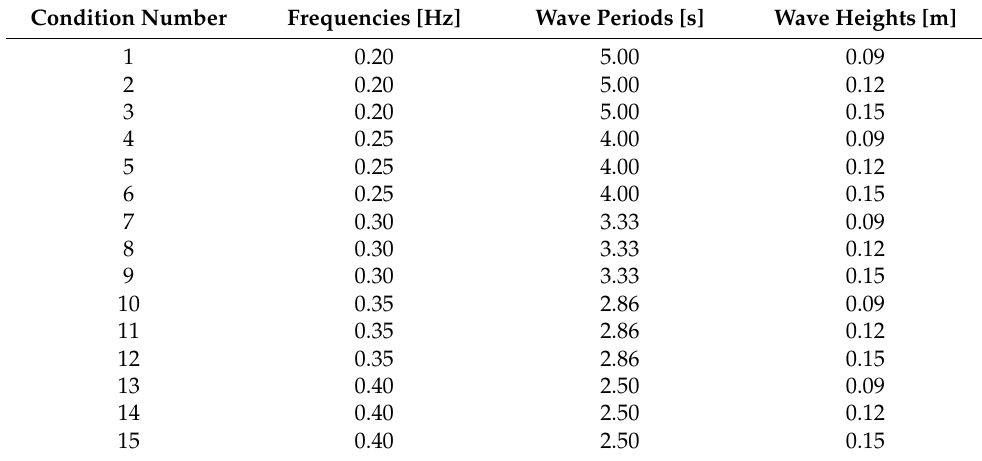
Table 2. Working condition of wave